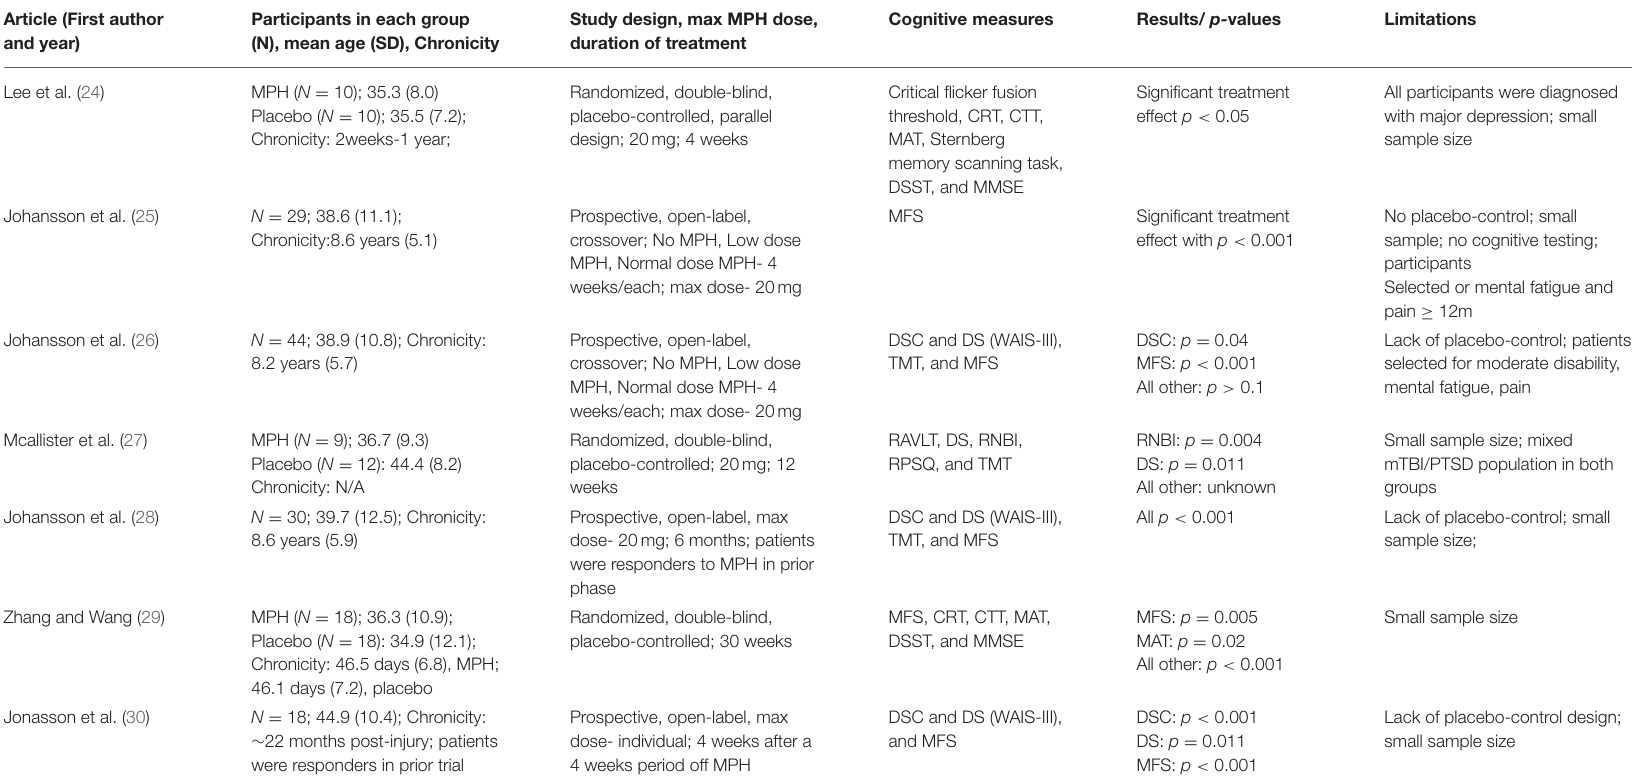
TABLE 2 | Clinical Trials of Methylphenidate in Adults with History of Mild to Moderate